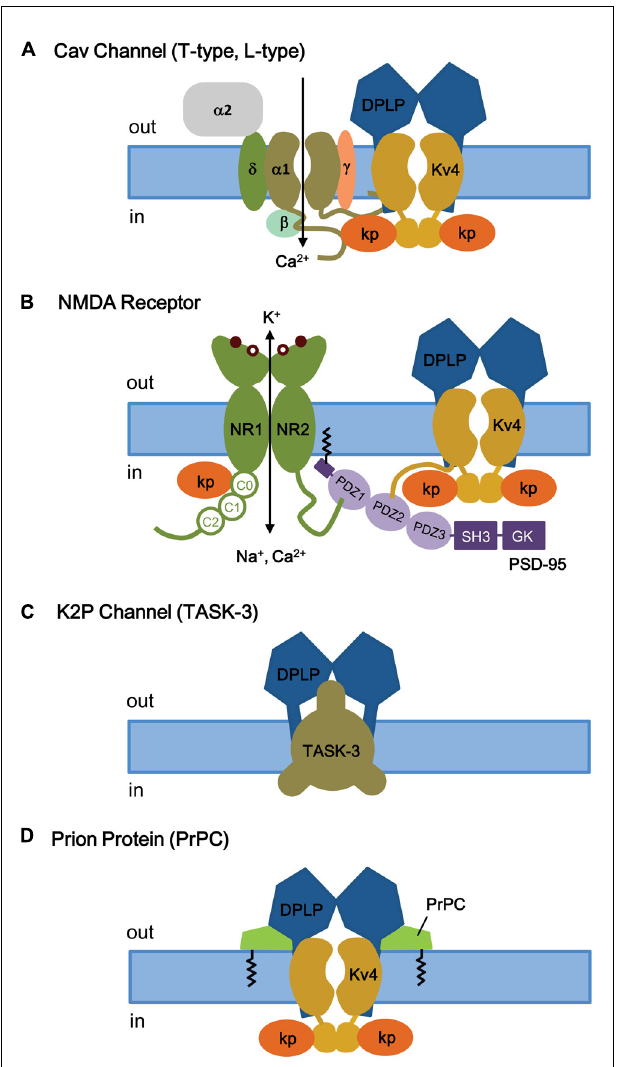
FIGURE 8 | KChIP and DPLP are also involved in binding and regulating other channels and receptors. (A) T- and L-type Cav channels. Depolarization-activated Cav channels, like I SA channels, are multi-protein complexes.The cytoplasmic N- and C-termini of Cav channels have been shown to interact with the I SA channel complex, via Kv4 or KChIP subunits. (B) NMDA receptor.The NMDA receptors are opened by 2 simultaneous events: activation by extracellular ligand binding and depolarization- mediated relief of block by Mg 2 + (coincidence detector). Both NMDA receptor and I SA channels are localized post-synoptically, and KChIPs have been shown to regulate NMDA receptor activities. (C) TASK-3 two-pore K + channels. DPP6 co-assembles withTASK-3 channels in the dendritic membrane to regulate membrane excitability. (D) Prion proteins (PrPC) bind to DPP6, thereby regulating I SA expression and gating. Kp, KChIP; NR1, glycine-binding subunit; NR2, glutamate-binding subunit; SH3, SRC homology 3 domain; GK, guanylate